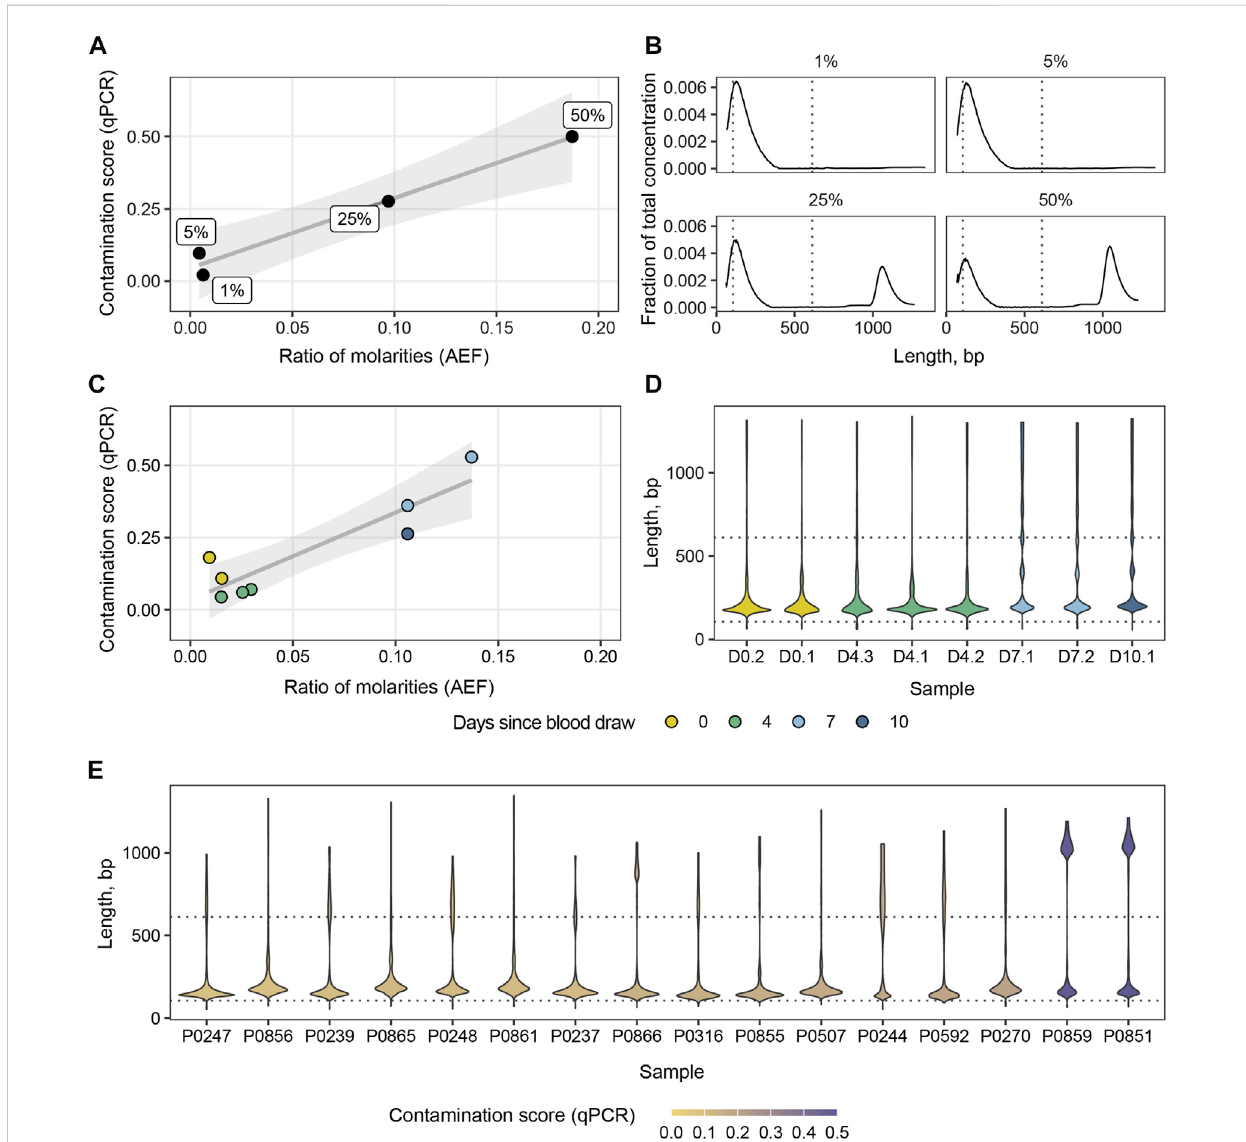
FIGURE 3 Ratios of molarities derived from AEF data versus contamination scores computed from qPCR for the panel of standard samples (A) and cfDNA samplesstoredforvariousperiodsoftimeincollectiontubes (C) .DistributionofcfDNAconcentrationforthepanelofstandardsamples (B) .Violinplotsof cfDNAconcentrationdistributionsforbloodsamplesstoredforvariousperiodsoftime (D) andasetofclinicalsamples (E) .Dottedlinesindicateamplicon